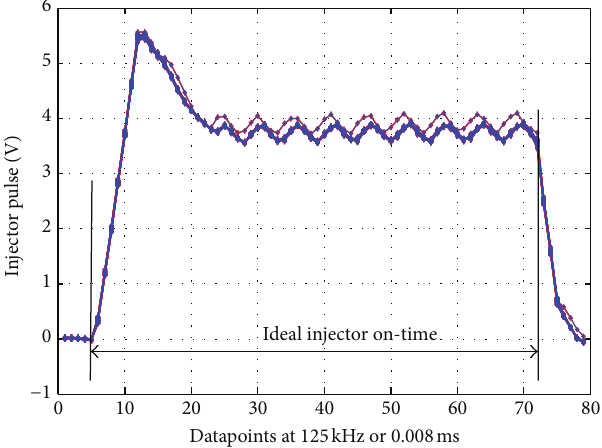
Figure 2: Injector pulse captured by the data acquisition system.